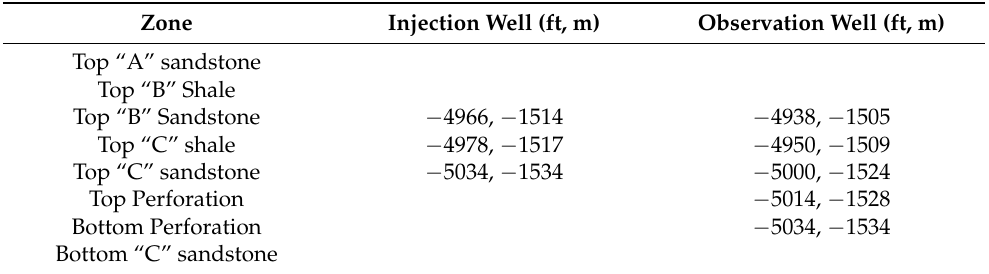
Table 1. The shale, sandstone, and perforation regions of the injection and observation wells. Zone Injection Well (ft, m) Observation Well (ft, m) Top “A” sandstone